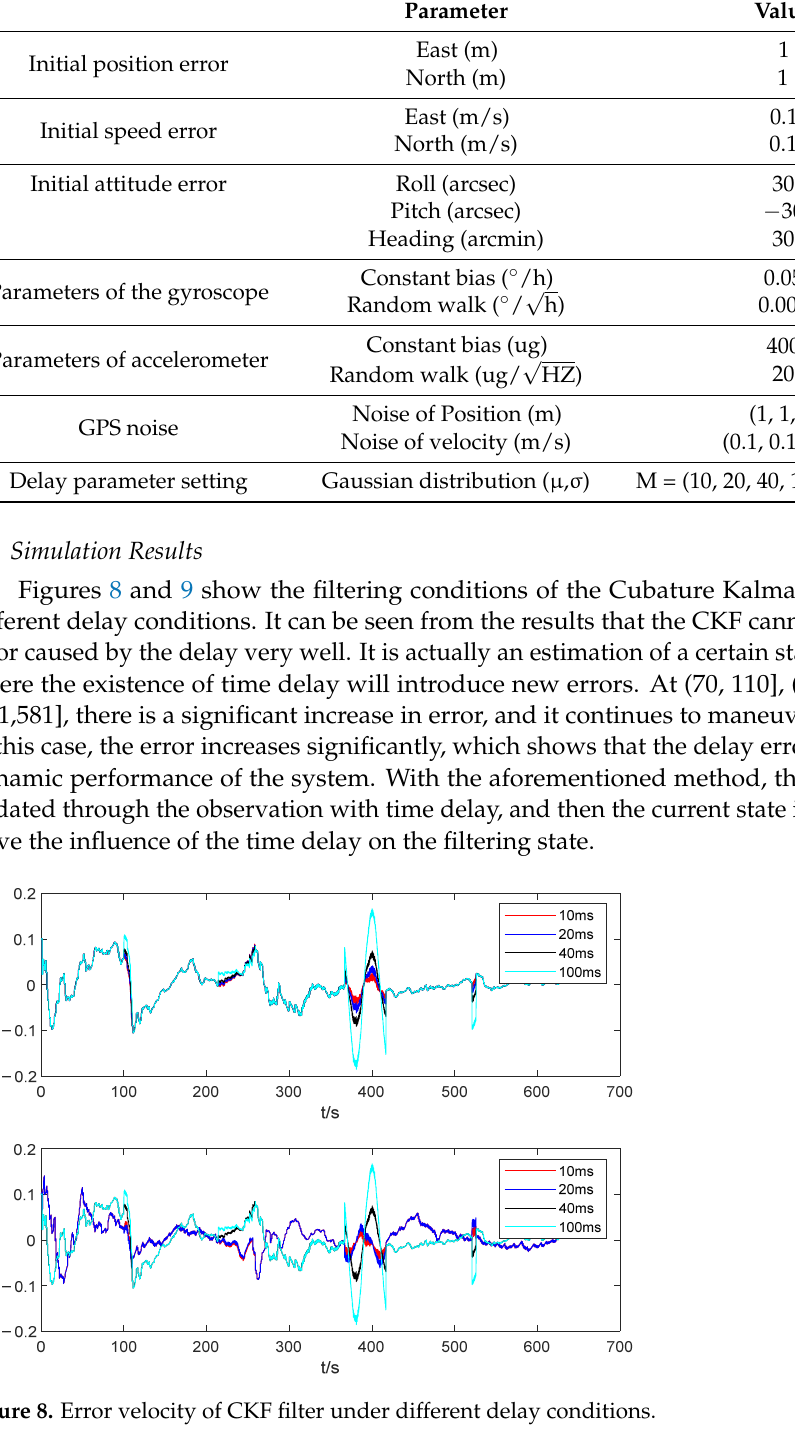
Table 2. Simulation parameter.